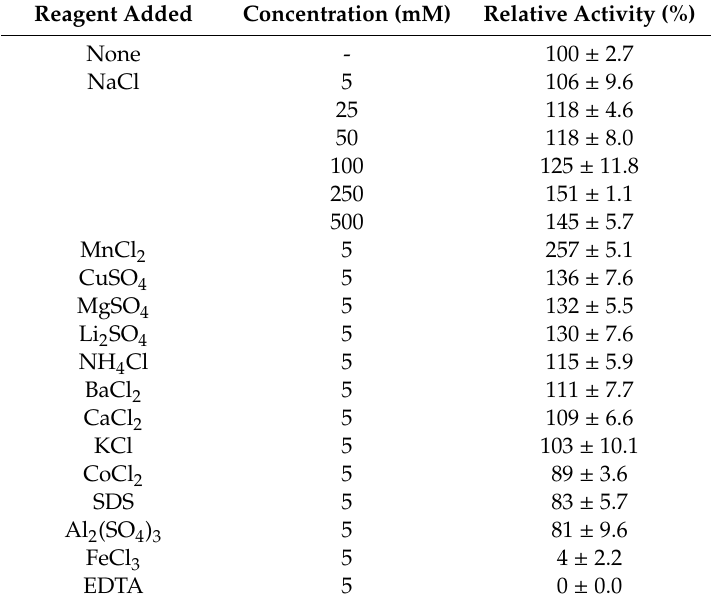
Table 1. E ff ects of metal ions, EDTA and SDS on the activity of